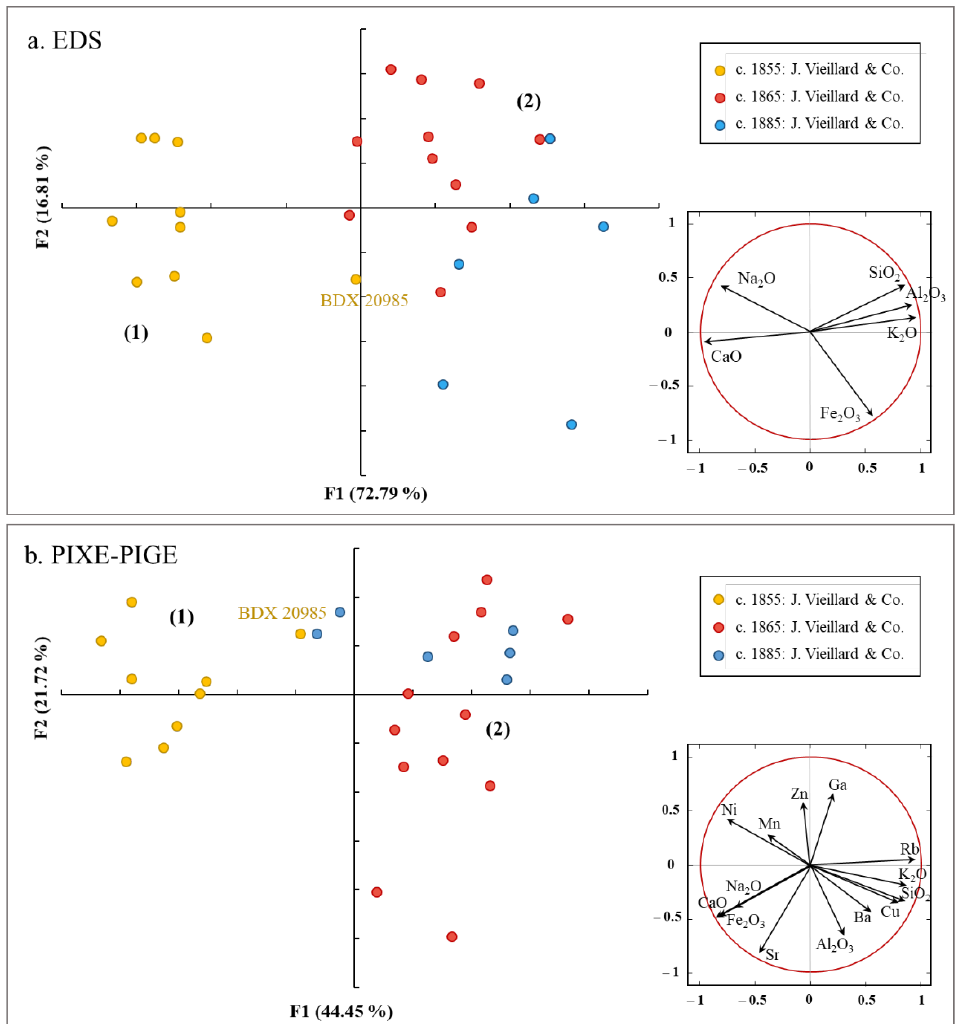
Figure 8. PCA score/loading plot obtained with ( a ) EDS and ( b ) PIXE-PIGE data of some detected elements in the glazes.